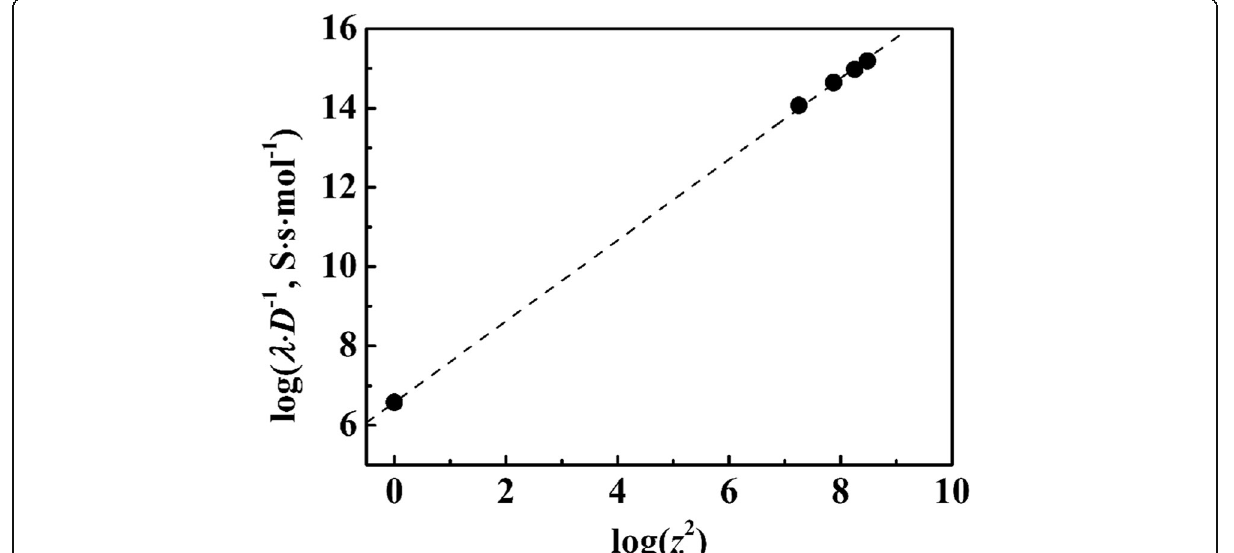
Fig. 5 Logarithmic plot of λ · D − 1 against z 2 for the four PSA suspensions and halide ions